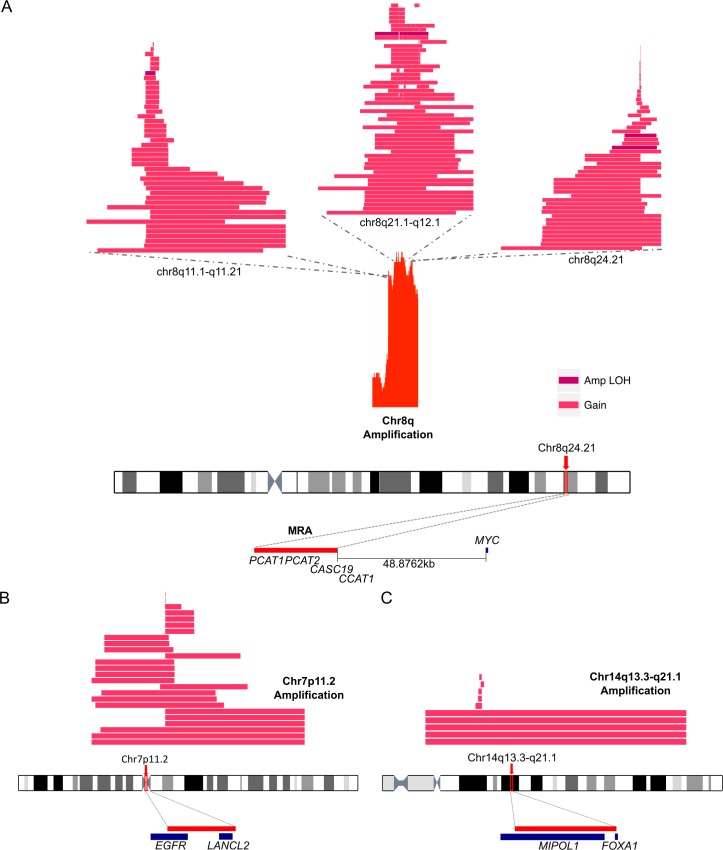
Examples of gains.Gains within the (A) q arm in Chr8, (B) focal amplifications at 7p11.2, and (C) 14p11.2. Three spatially separated regions of gain were present at 8q24.21. The chromosome gain events are represented with distinct colour blocks depending on the type of SCNA: gain (any gain in the number of normal allele copies) and amplification LOH (loss of one allele with any gain of the remaining allele). The regions of SCNA are ordered by length: top-smallest, bottom-largest. The genomic location of the MRAs and linked genes are additionally displayed.